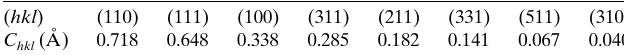
Table 9 Magnitudes of C hkl in CaF 2 [fluorite structural type, space group type Fm (cid:4) 33 m , the structure is reported by Speziale & Duffy, 2002)].